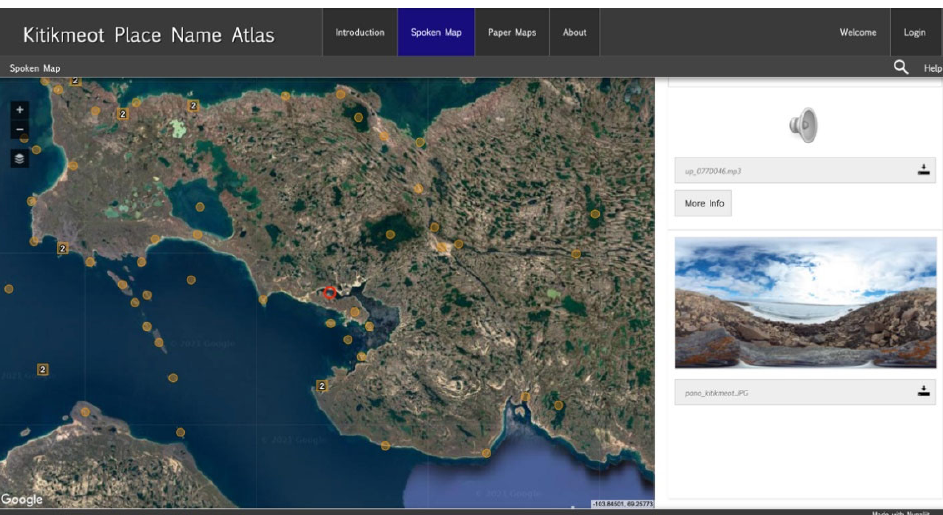
Figure 3. A video of elder Frank Analok is linked to the Tikiraaryuk site and describes its history of use for seal hunting and iglu building. Each yellow dot on the map represents a unique place name and associated data.